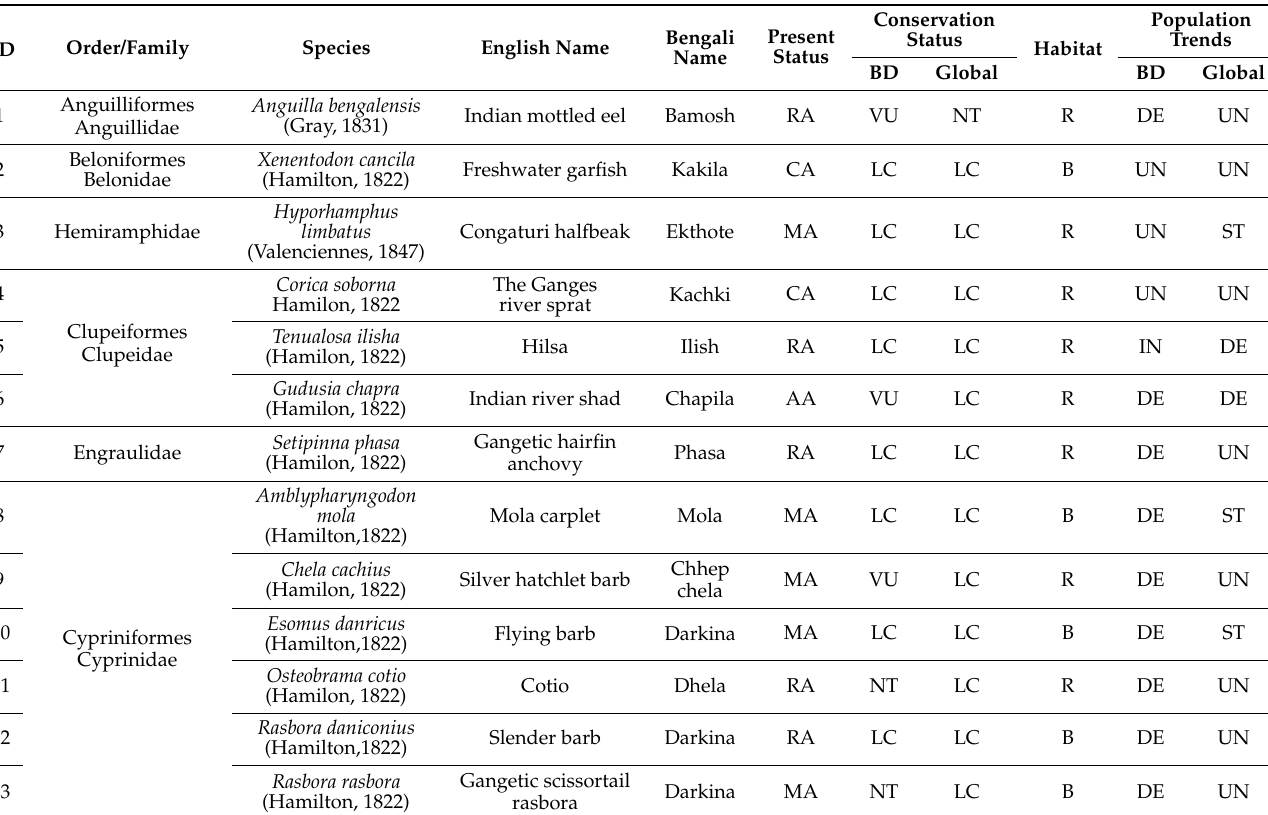
Table 1. List of recorded fish species in the Dhanu River and surrounding beels (BD = Bangladesh; Present status: AA = Abundantly Available, CA = Commonly Available, MA = Moderately Available, RA = Rarely Available; Conserva- tion status: NE = Not Evaluated, NT = Near Threatened, LC = Least Concerned, VU = Vulnerable, EN = Endangered, DD = Data Deficient, CR = Critically Endangered; Habitat: B = Beel , R = River; Population trend: IN = Increasing, ST = Stable, DE = Decreasing, UN =